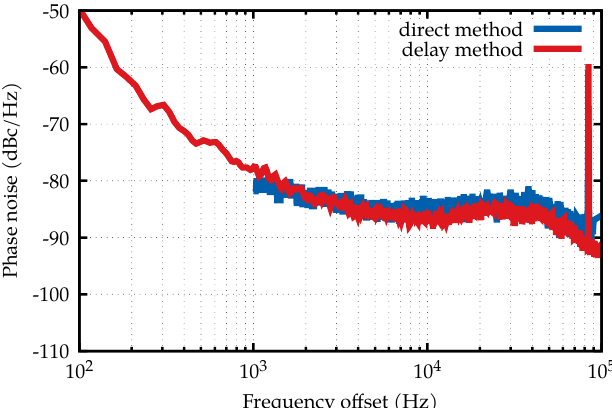
Figure 6. Comparison of the phase noise measured with the direct method by a commercial spectrum analyzer and the presented phase noise meter with photonic delay.